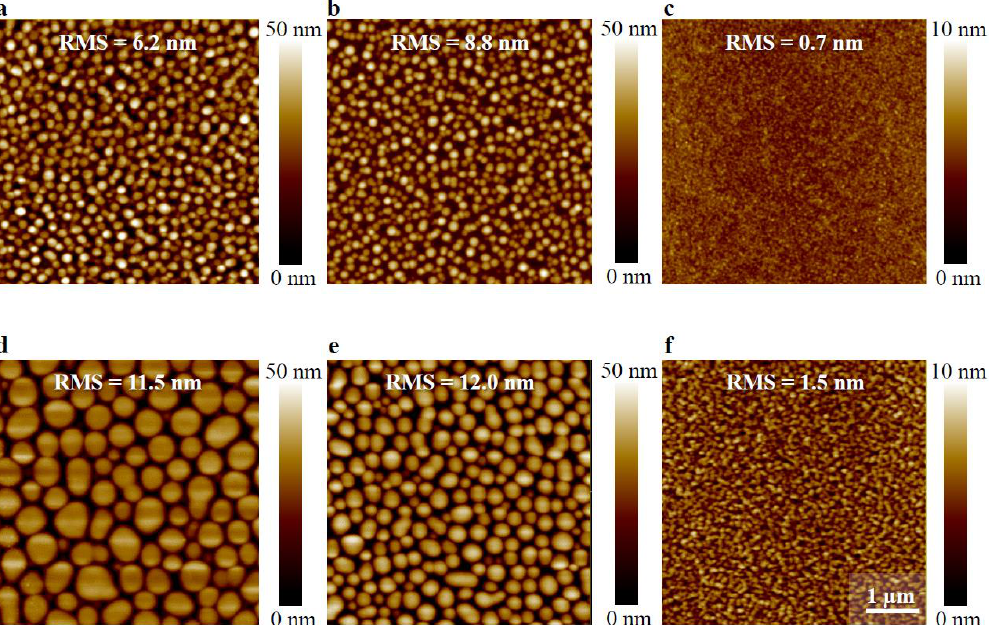
Figure 2. Atomic force microscopy (AFM) micrographs (5 × 5 µ m) of thin films of 1:1 TQ1:PC 70 BM ( a – c ) and 1:3 TQ1:PC 70 BM ( d – f ) spin-coated from chloroform (CF) ( a , d ), chlorobenzene (CB) ( b , e ), and ortho- dichlorobenzene ( o DCB) ( c , f ). Scale bar indicates 1 µ m. Surface roughness (RMS), as well as the corresponding height scale, is added to each image.